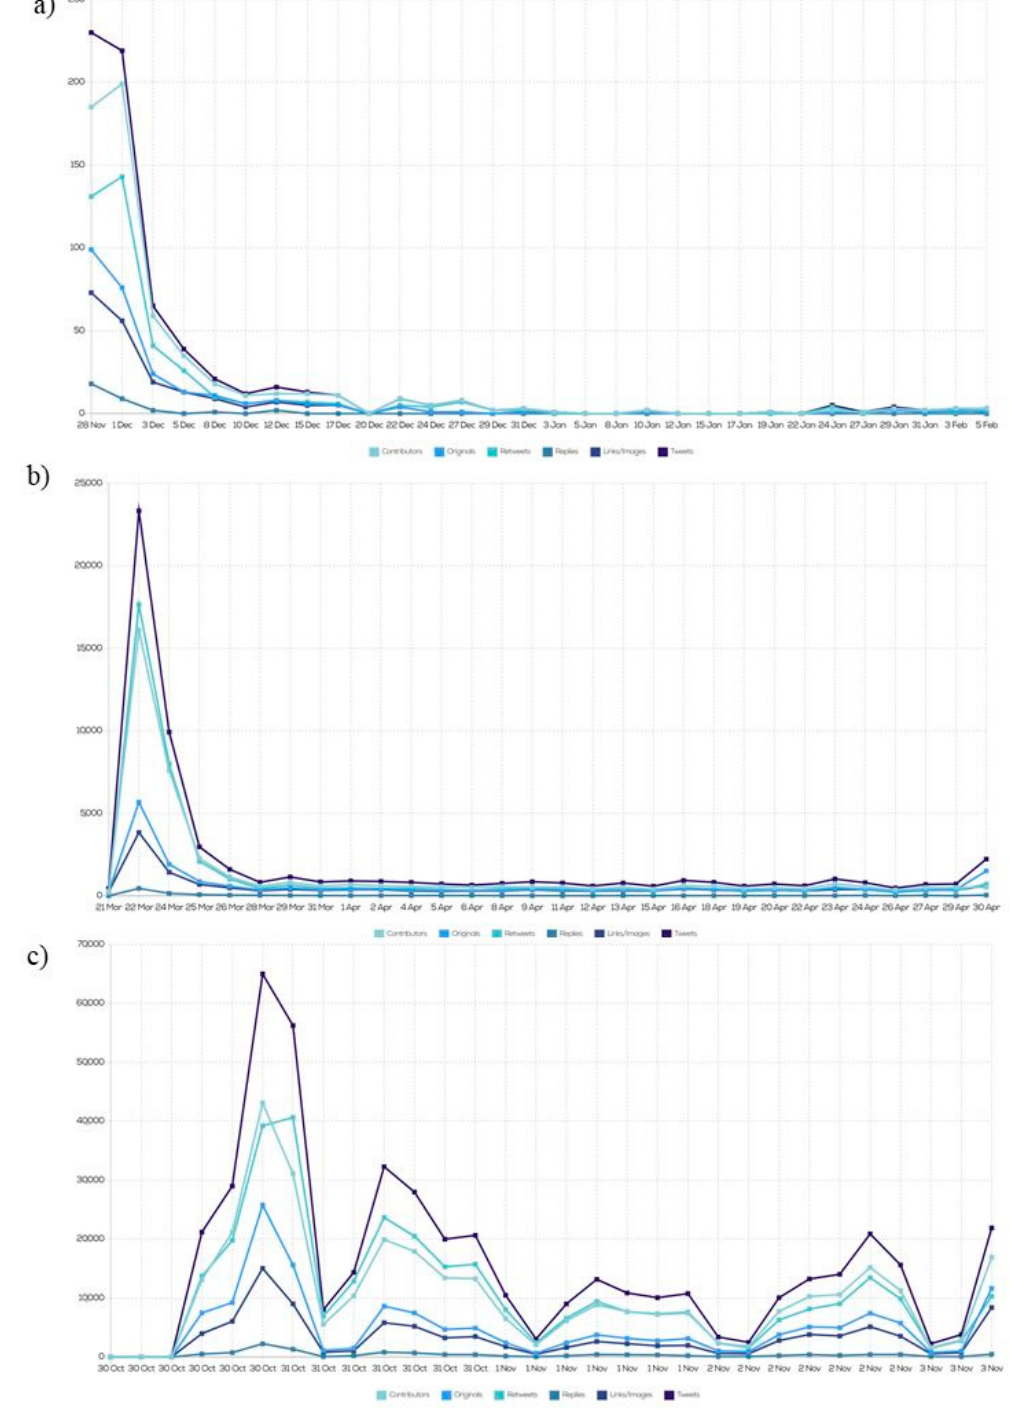
Figure 12. Twitter activity related to ( a ) 2019 Albania earthquake; ( b ) 2020 Zagreb earthquake; ( c ) 2020 Aegean earthquake. Adapted from: TweetBinder.